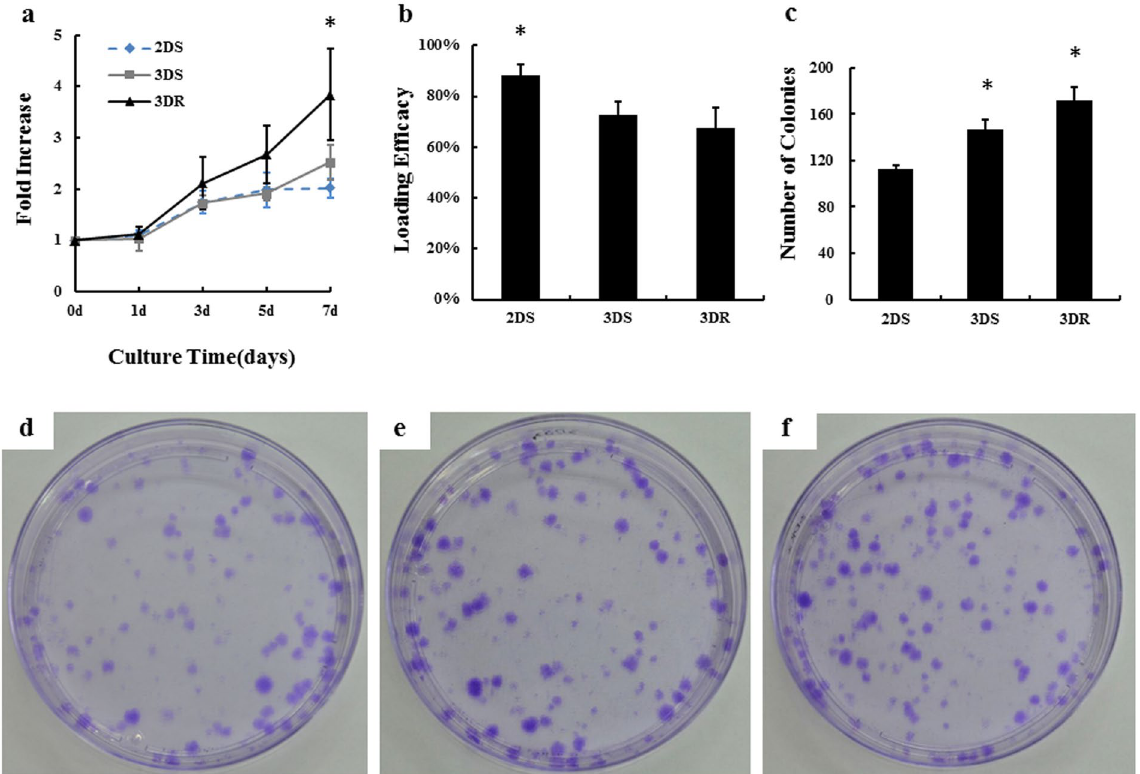
Figure 5. Cell number and CFU analysis of BMSCs cultured in static-2D, static-3D and RCCS-3D groups. ( a ) Proliferation curves of BMSCs in static-2D, static-3D and RCCS-3D groups. The fold increase of cell number was calculated at 0, 1, 3, 5 and 7 day, normalized with the fold increase of cells was set as 0 on the seeding day. The difference on the 7th day was significant by one-way ANOVA analysis ( * p < 0.05). ( b ) Loading efficacy of cells in static-2D, static-3D and RCCS-3D groups. ( c ) Statistical analysis of colony numbers of BMSCs in each group (n = 3, * p < 0.05). ( d–f ) Morphology of colonies formed by the cells in static-2D group ( d ), static-3D group ( e ) and RCCS-3D group ( f ) and the colonies were stained with crystal